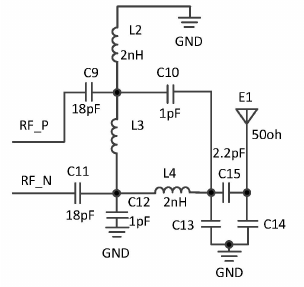
Figure 6. RF transceiver module